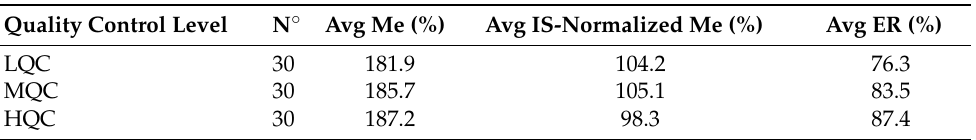
Table 6. Average (Avg) Matrix effect (ME%) and Recovery (ER%) of DBV measured at different concentration levels for